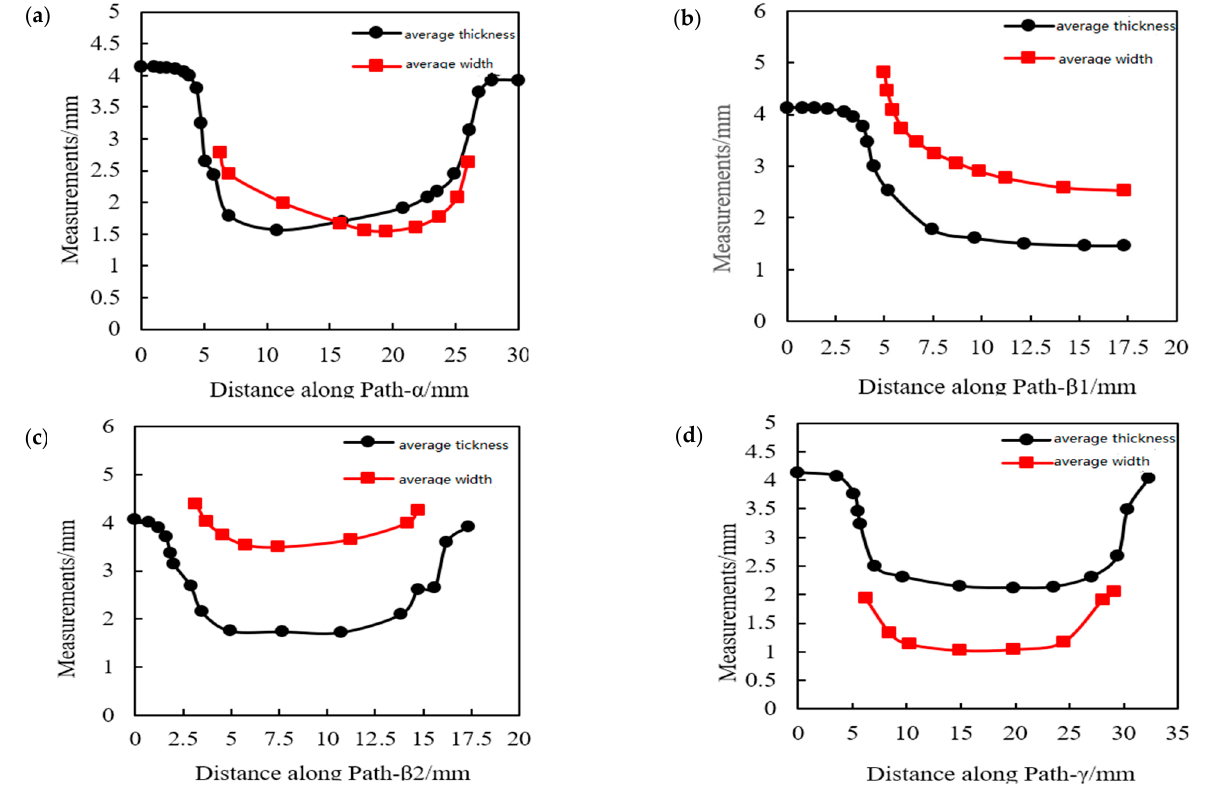
Figure 20. Distribution of average thickness and width of ribs along each path. ( a ) Path- α , ( b ) Path- β 1, ( c ) Path- β 2, and ( d ) Path- γ .